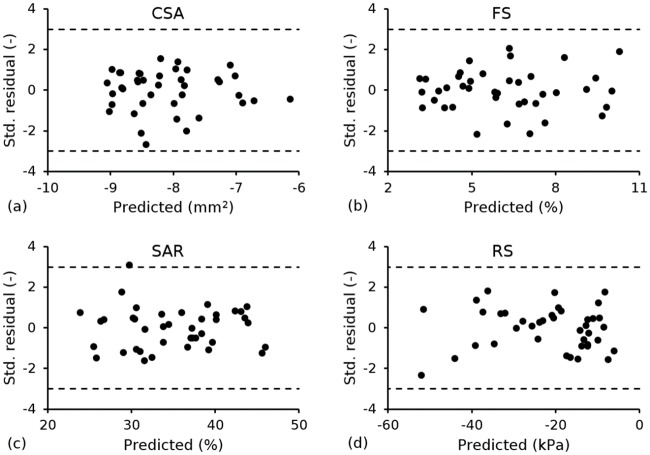
Standardised residual vs. predicted response using the statistical model in Eq 16 for (a) CSA; (b) FS; (c) SAR and (d) RCP.